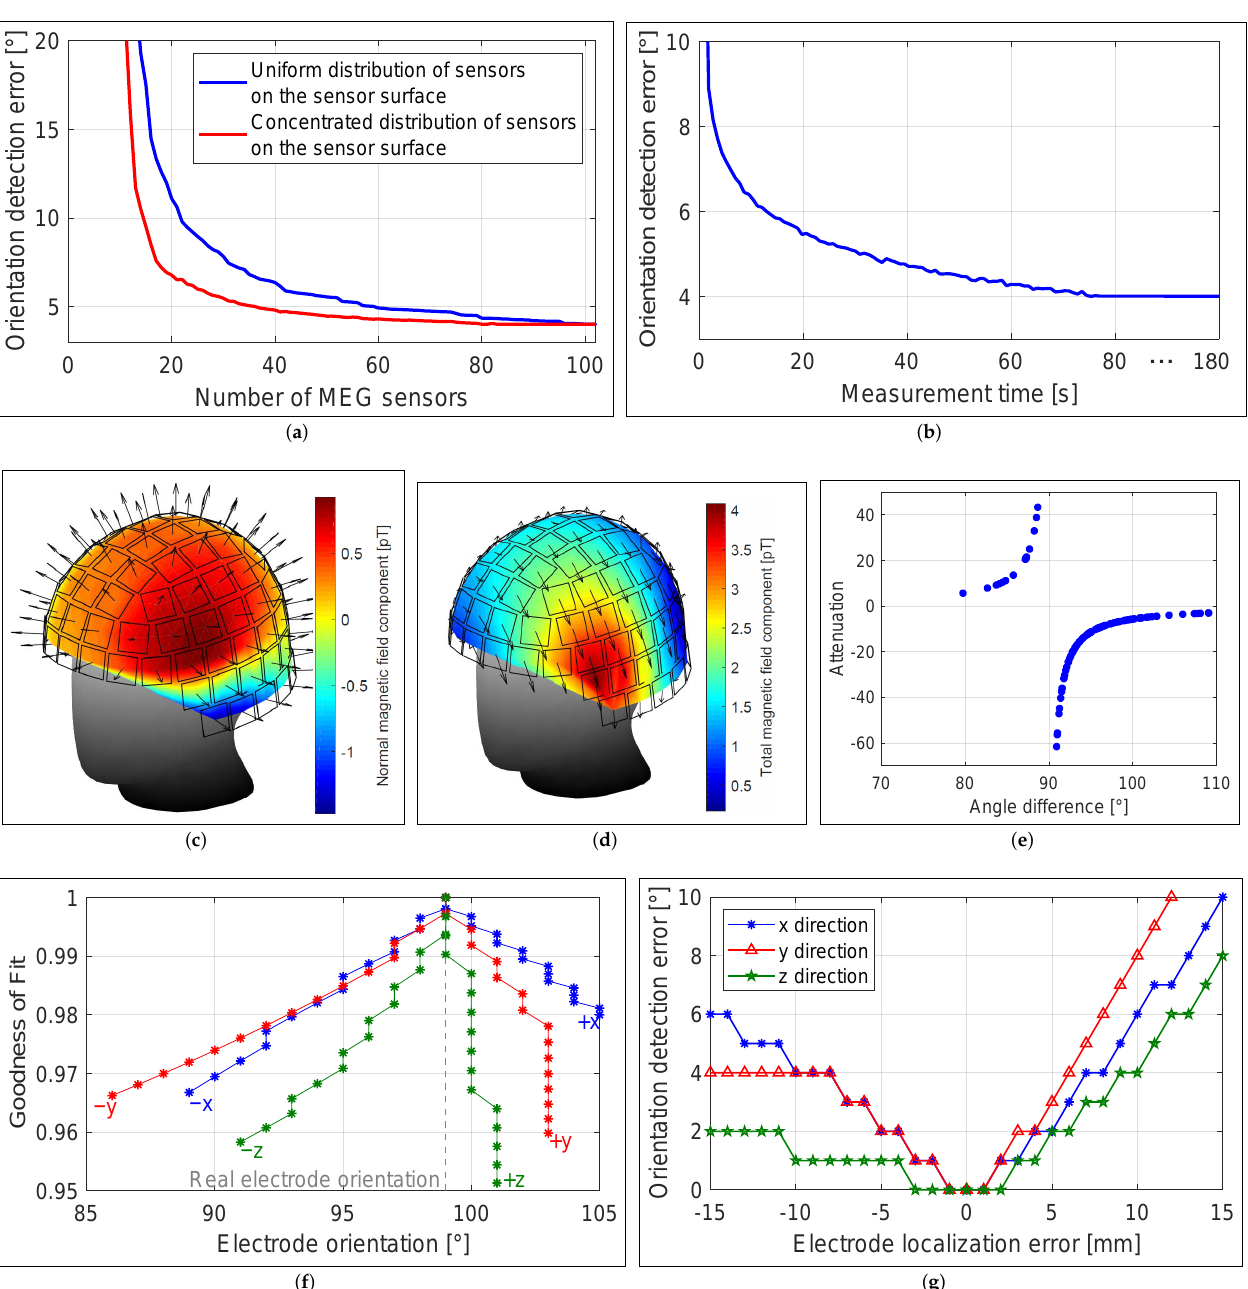
Figure 14. Orientation detection error as a function of ( a ) the number of MEG sensors and their distributions distributions and ( b ) the recording time of each measurement. ( c ) Measured magnetic field distribution with horizontal electrode configuration. Arrows indicate the orientations of the MEG sensors. ( d ) Expected magnetic field distribution for the magnitude of the magnetic field. Arrows indicate the direction of the magnetic field. ( e ) Attenuation of the measured magnetic fields due to the angle between the orientation of the MEG sensor and that of the magnetic field. ( f ) GoF value and ( g ) detection error as a function of electrode localization